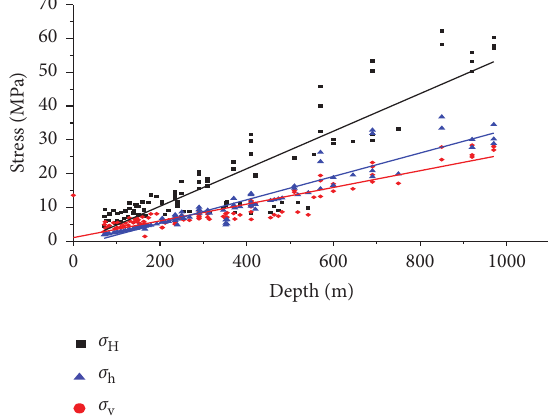
Figure 6: Relationship diagram of principal stress variations with depth in northwest Jiaodong.